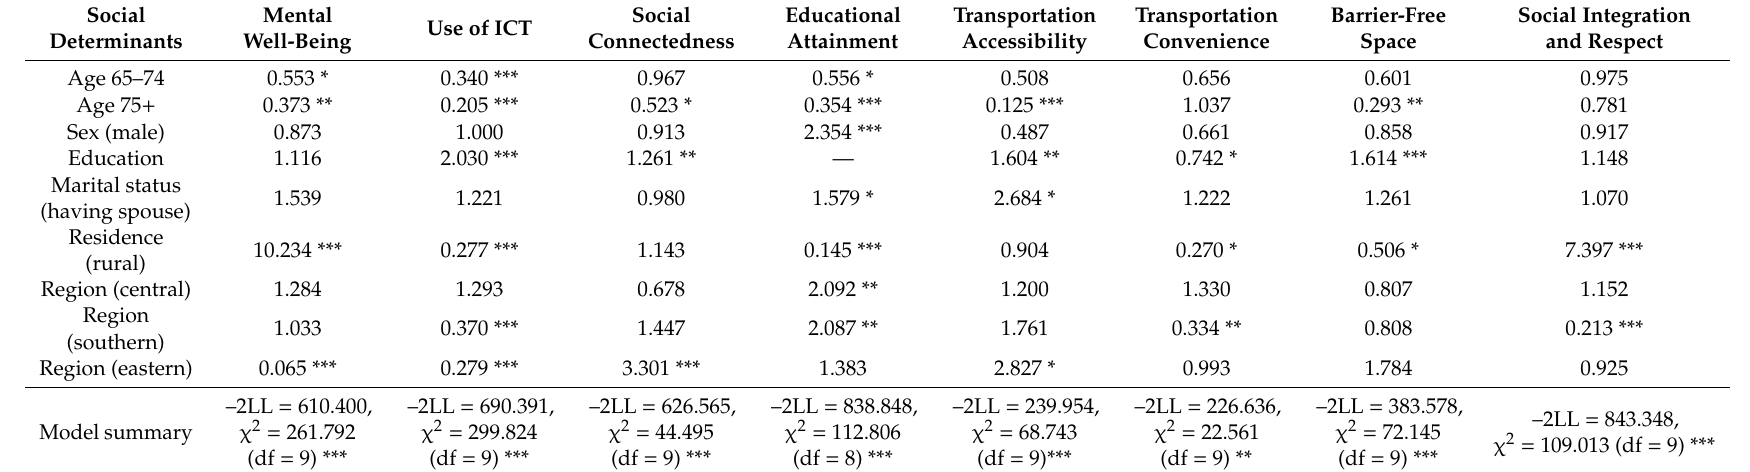
Table 5. Capacity of active aging and supportive environment indicators and social determinants by logistic